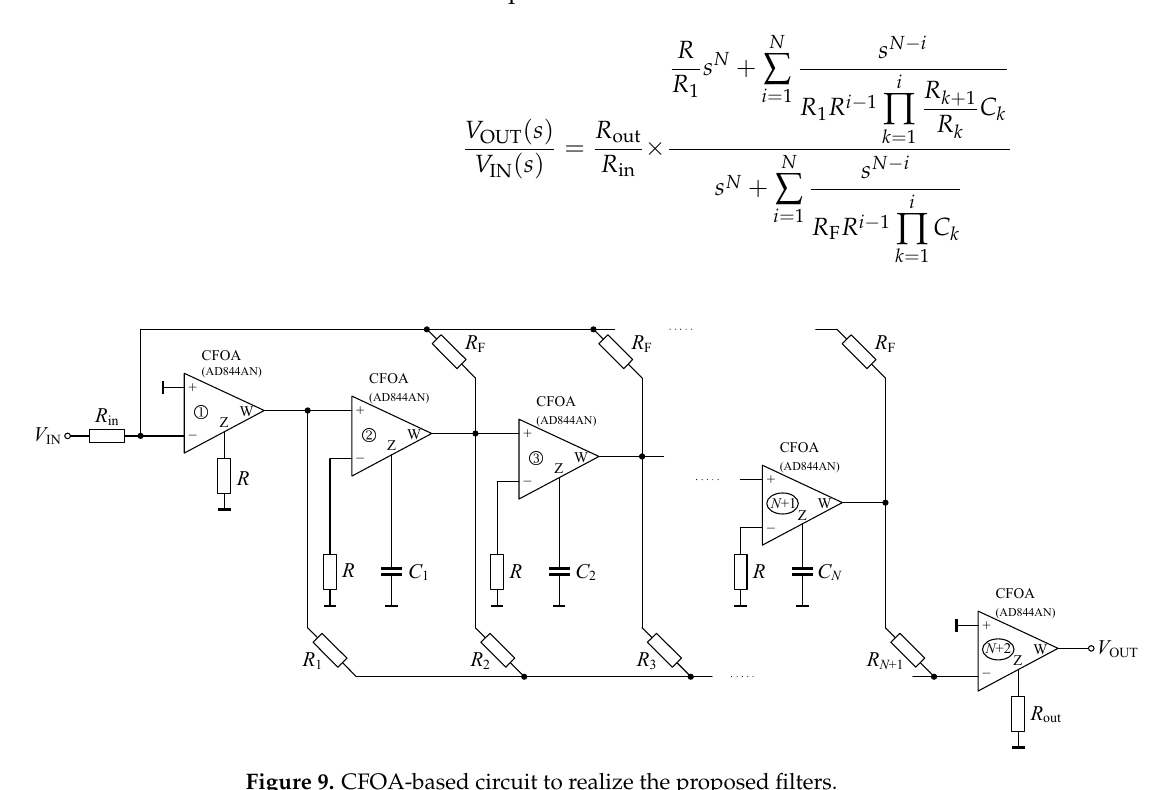
Figure 9. CFOA-based circuit to realize the proposed filters. The transfer functions of the proposed filters, as given by (10)–(17), are chosen as demonstrative cases for circuit realization.